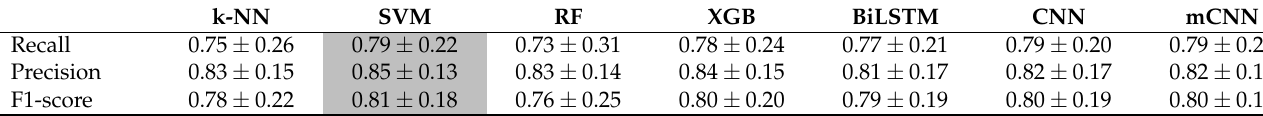
Table 3. This table shows the average recall, precision, and F1-score of the leave-one-subject-out cross-validation. Twelve labels are merged into nine physical activities by summing up the corresponding rows/columns of the summed confusion matrix. The best results are shown as gray cells. The term “mCNN” is an abbreviation for “multi-resolution CNN”.